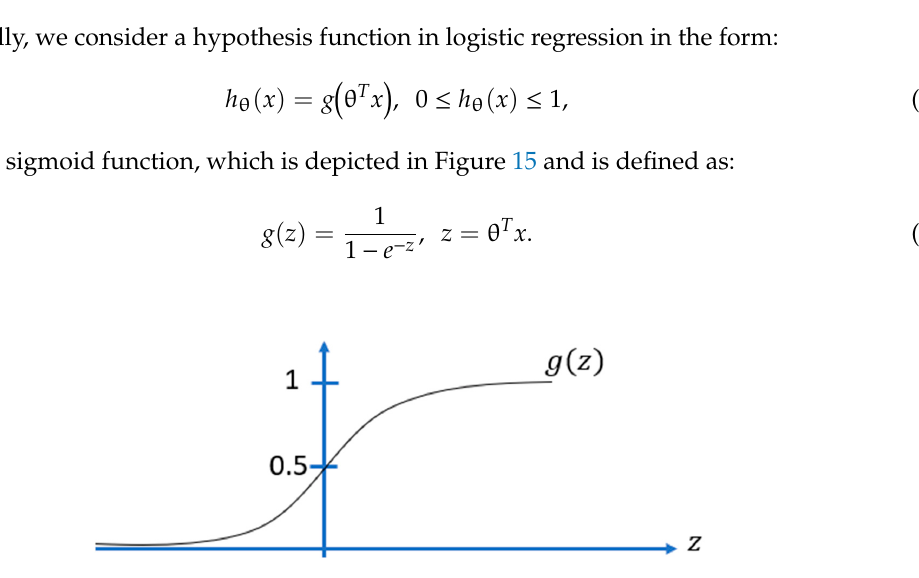
Figure 14. Schmatic representaiton of the machine learning model.